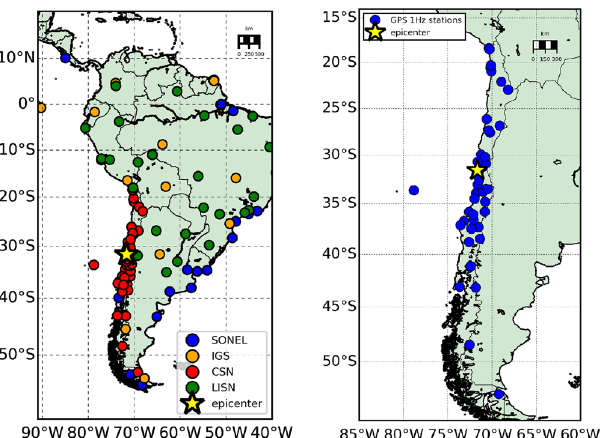
Figure 1. Left—Map with the epicenter of the earthquake and the 118 GPS permanent stations at low-rate data sampling (10, 15, 30 s) used in VARION processing for sTEC variation estimation; GPS stations from CSN, SONEL, IGS and LISN in red, blue, orange and green respectively. Right—Map with the epicenter of the earthquake and the 44 GPS permanent stations at high-rate data sampling (1 s) used in VADASE processing for ground shaking and kinetic energy estimation: CSN stations in